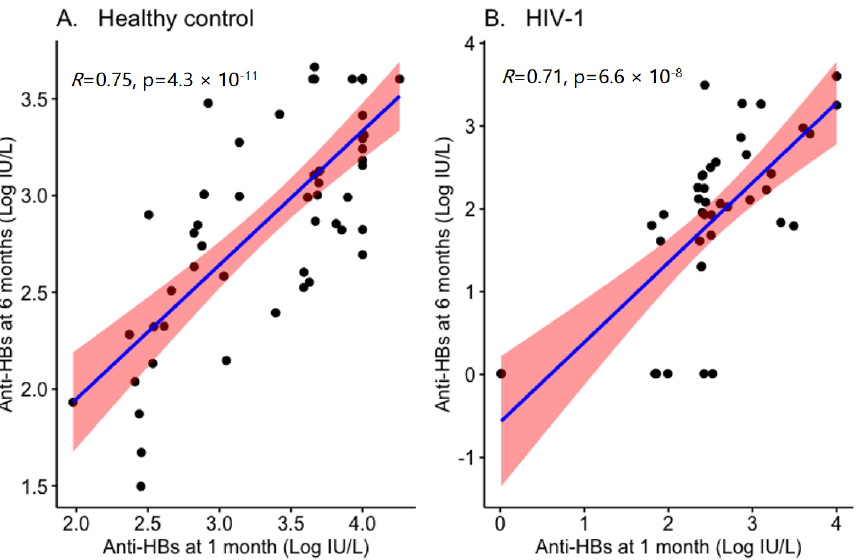
Figure 1. Correlation of anti-HBs titer at 1 and 6 months from completed HBV vaccination. Three doses of HBV vaccine were administered to children who were negative for HBsAg and previously unvaccinated, and periphery blood was collected at 1 month and 6 months after the last vaccination. Direct correlation of anti-HBs titers at 1 month and 6 months from the last vaccination dose in both healthy controls ( A ) and ART-treated HIV-1 infected ( B ) children. Anti-HBs: Hepatitis B surface antibody; IU/L: international units per liter (Modified from [8,33]).